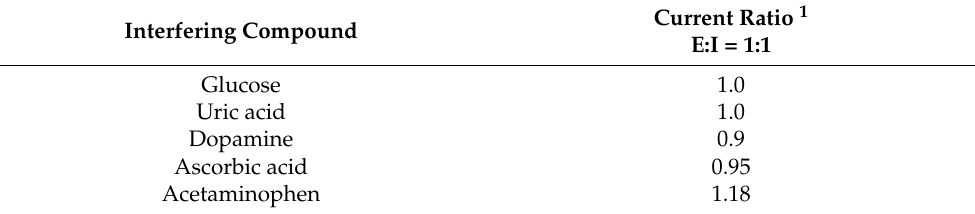
Table 2. Influence of interfering compounds on the detection of ethanol. Interfering